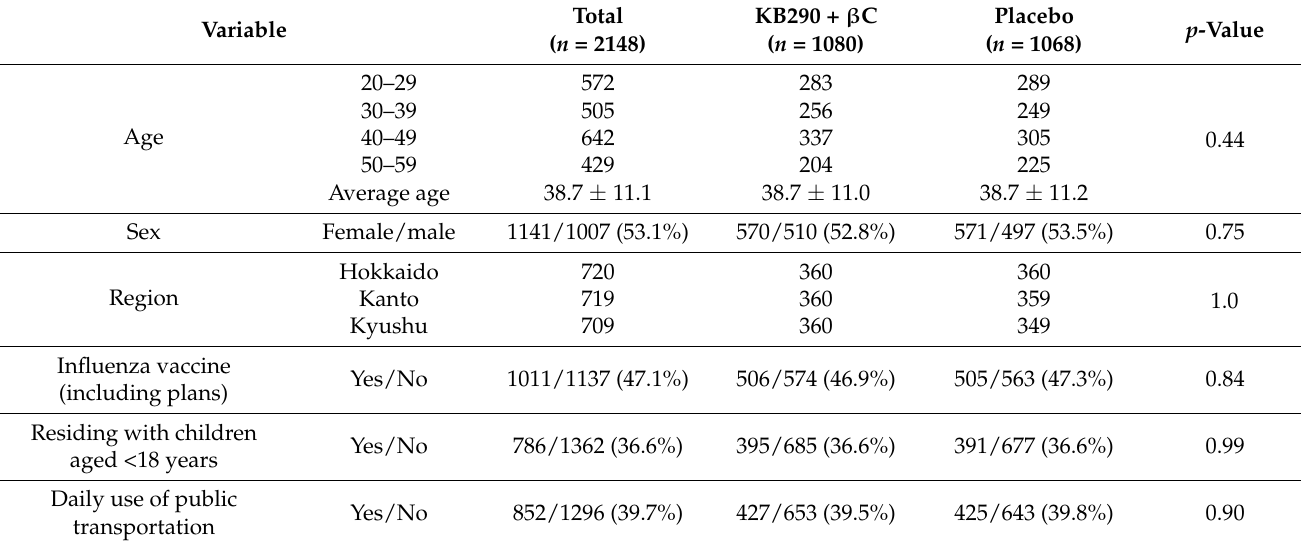
Table 1. Characteristics of the subjects evaluated with efficacy analyses in this trial 1 .